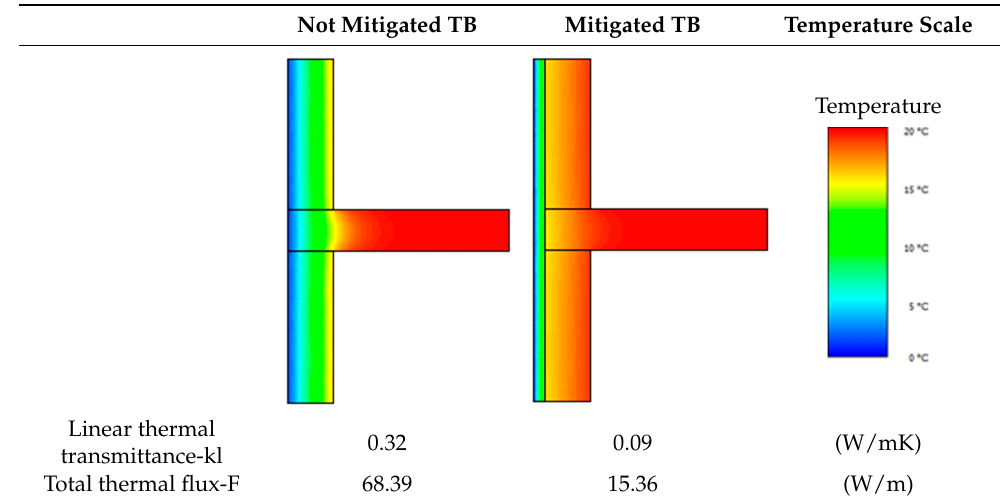
Table 12. IF Thermal bridges.